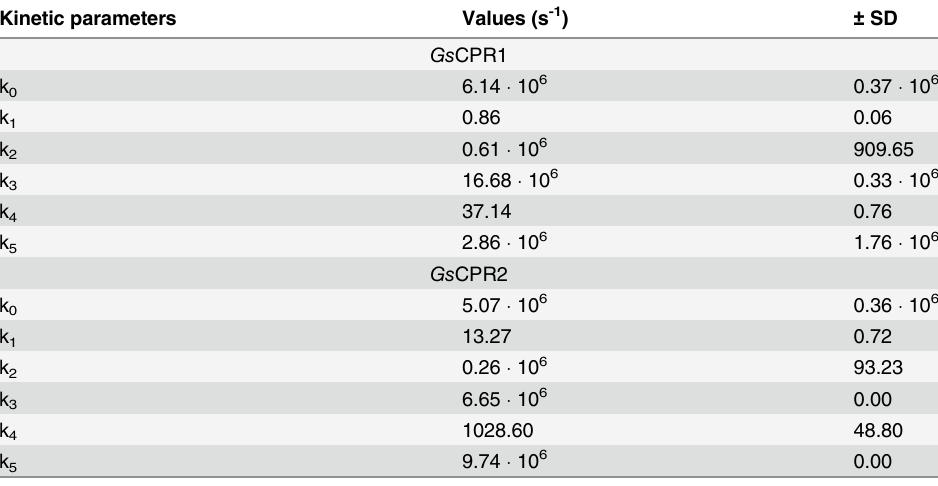
Table 2. Calculated kinetic parameters for Gs CPR1 and Gs